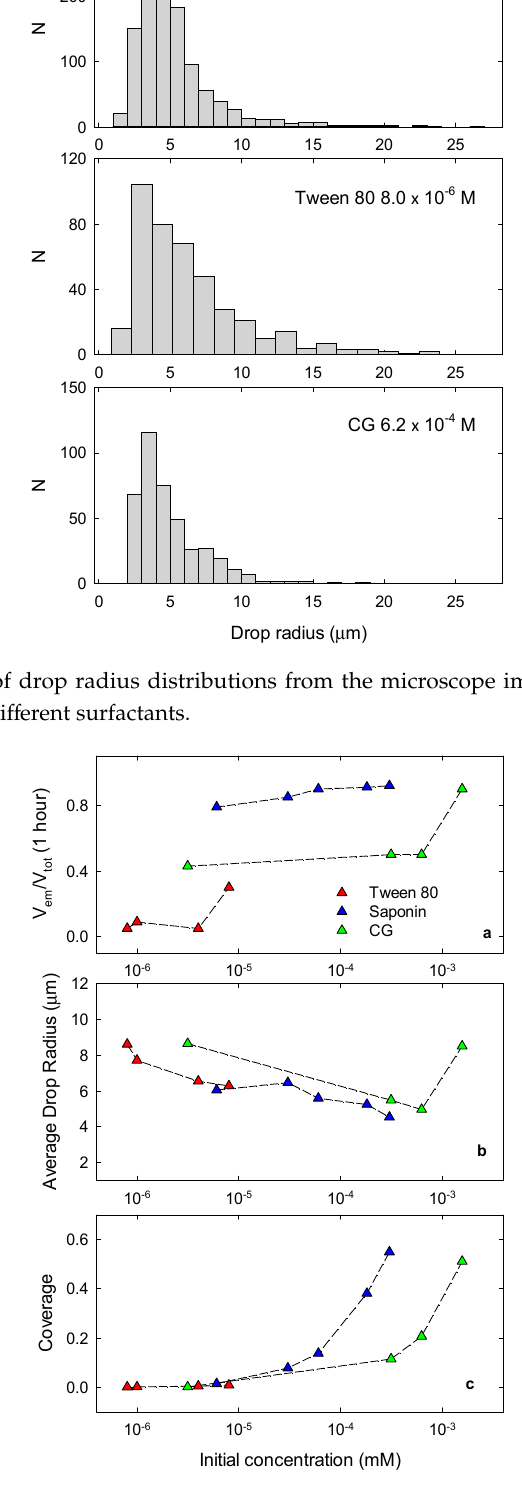
Figure 11. Relative emulsion volume at one hour from the emulsification ( a ), average emulsion drop radius obtained by microscopy images just after the emulsification ( b ) and surface coverage of oil drops in emulsions by the adsorbed surfactant ( c ), against the surfactant concentration in water before emulsification.